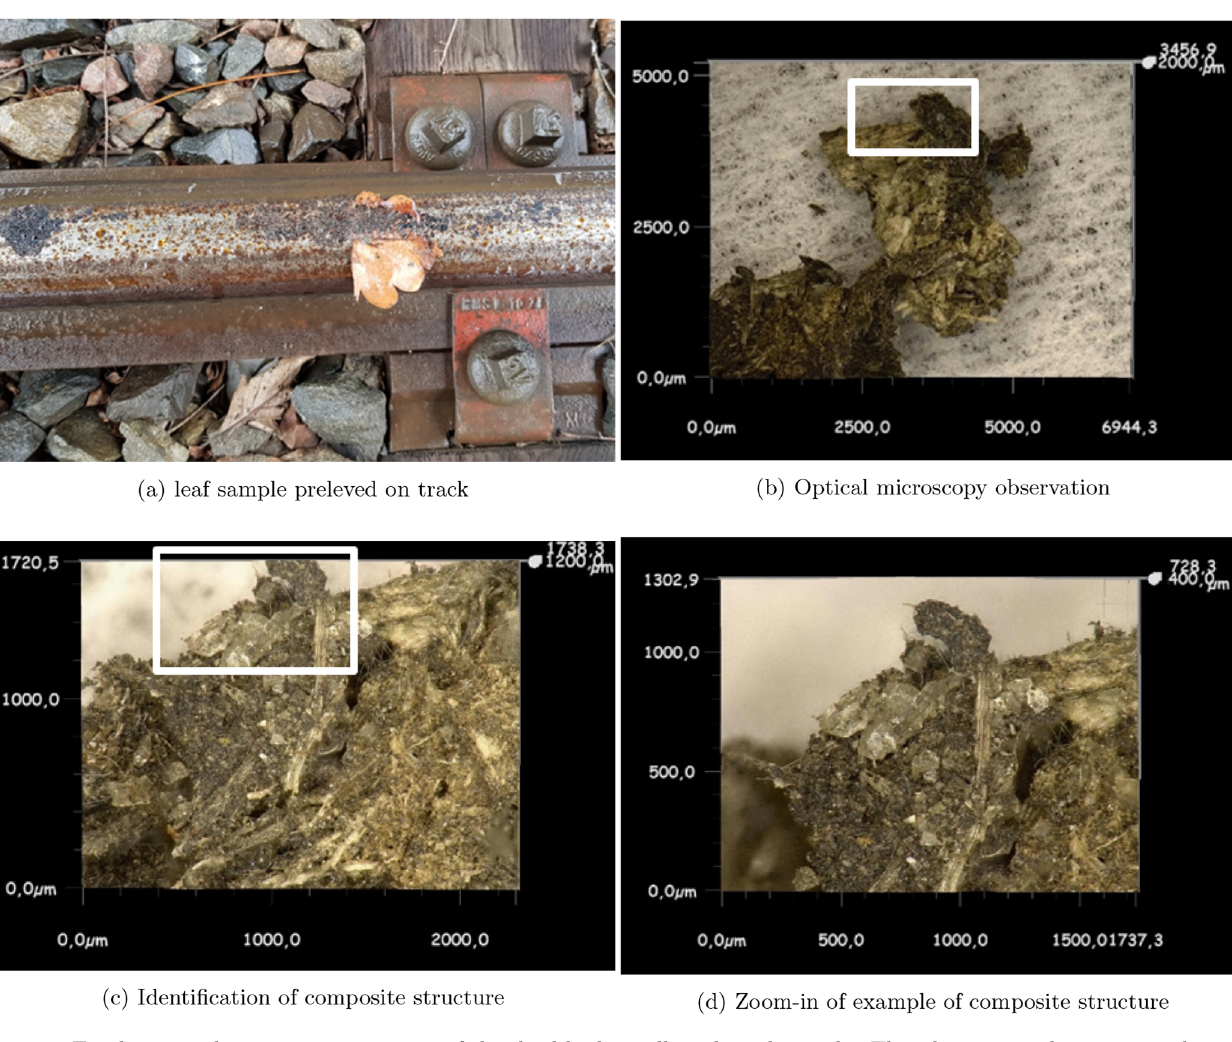
Fig. 25. Emphasis on the composite structure of the third bodies collected on the tracks. The white rectangles correspond to the areas observed at different